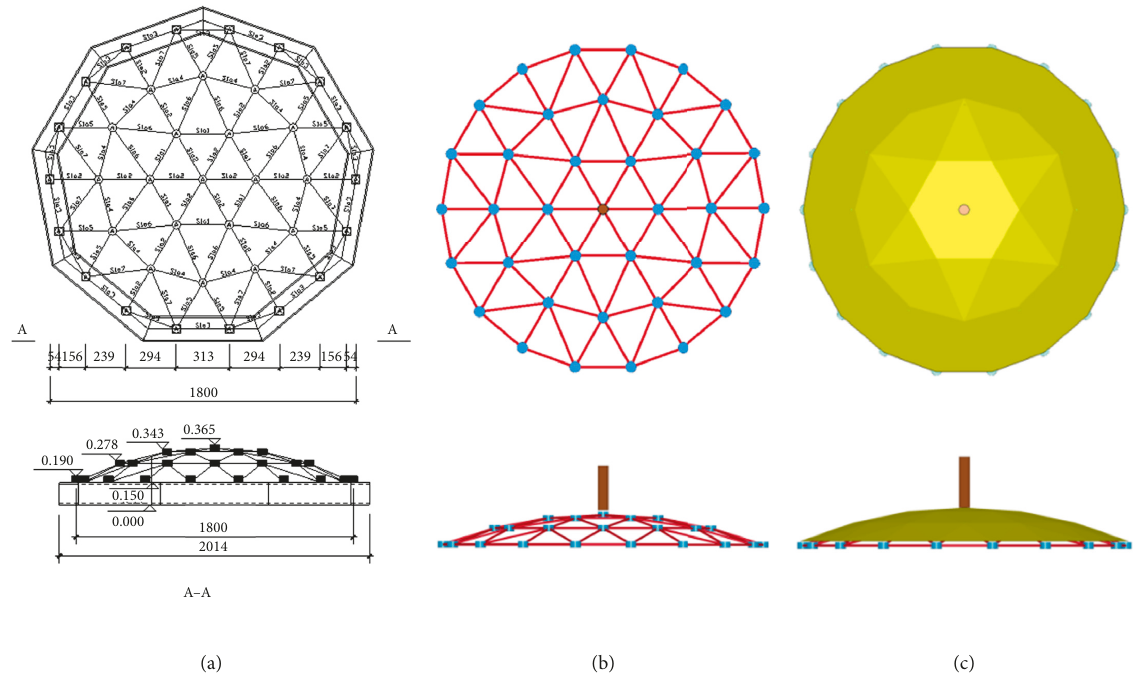
Figure 4: Scale model and numerical model. (a) Reticulated shell model of test. (b) Reticulated shell model without roof plate. (c) Reticulated shell model with roof plate.